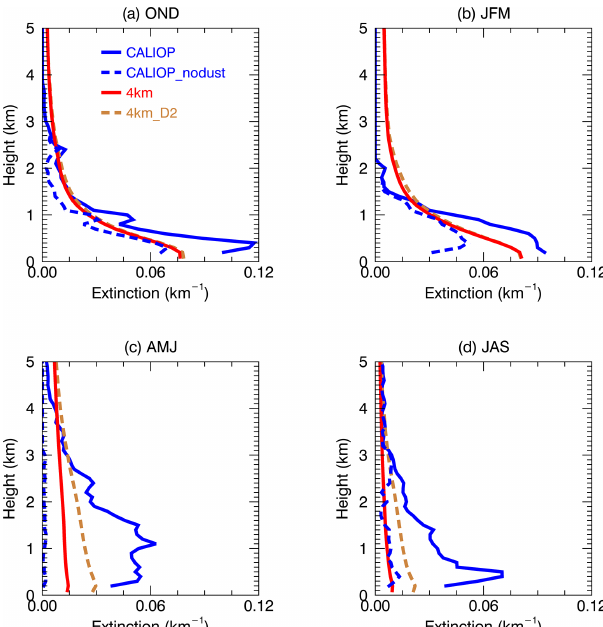
Figure 12. Vertical distribution of seasonal mean 532nm aerosol extinction coefficient (km − 1 ) from CALIOP (blue) and the WRF- Chem (4km and 4km_D2) simulations over the red box region in Fig. 1a in WY2013. Blue dashed lines (CALIOP_nodust) represent the CALIOP profiles without dust (dust and polluted dust).